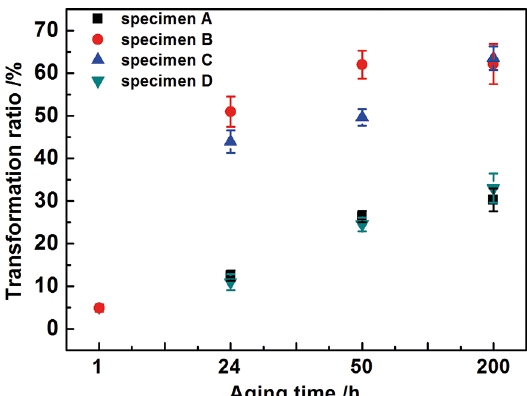
Figure 7. Transformation ratio of α→σ in specimens with different microstructure aged at 750 °C for different time.